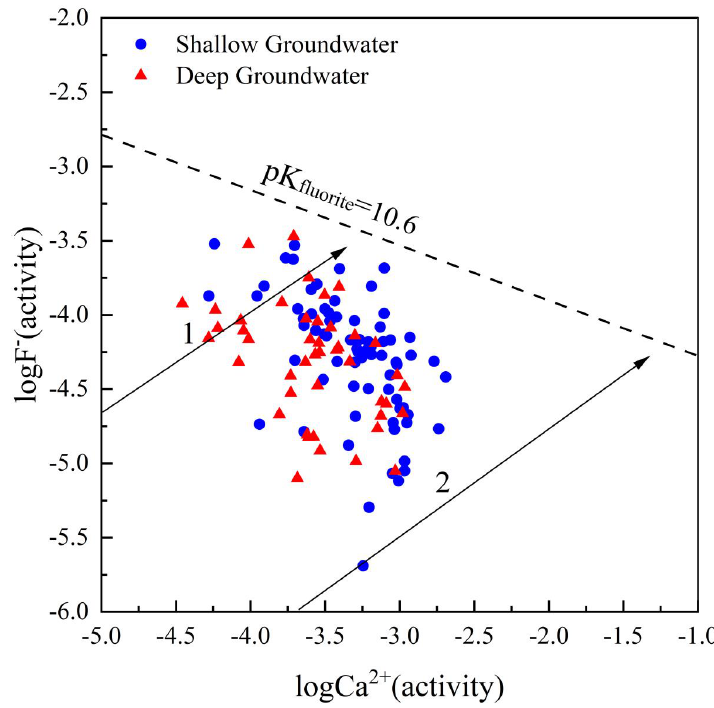
Figure 10. logF − (activity) vs. logCa 2+